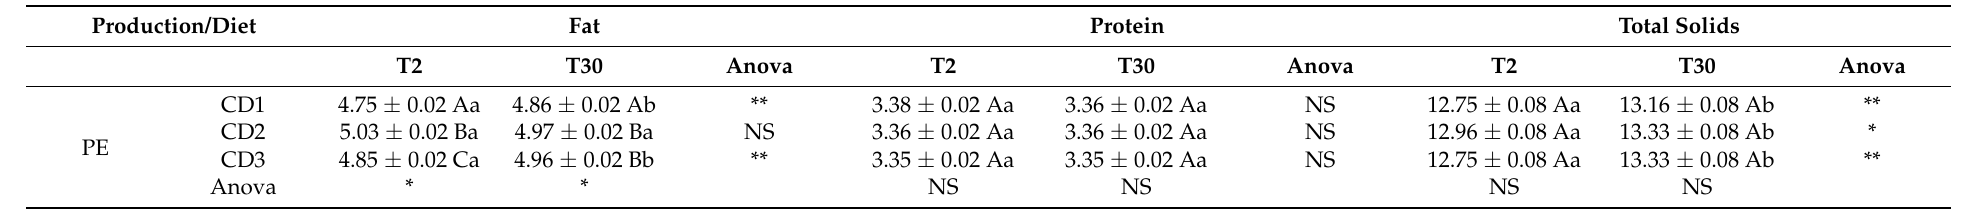
Table 3. Main components (fat, protein and total solids) content (g/100 g) in fermented milk manufactured and stored for 2 and 30 days with milk